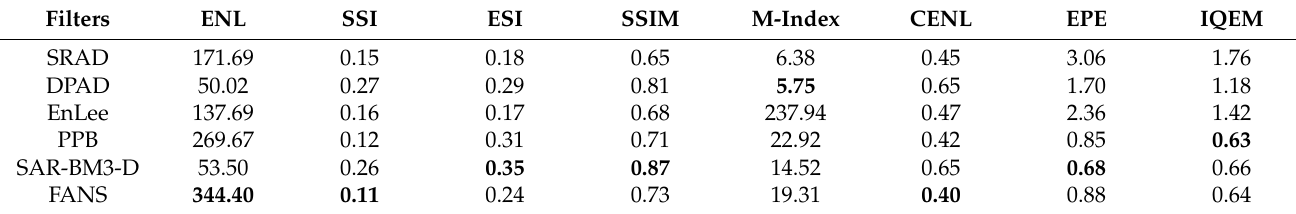
Table 3. Index evaluation of the GF-3 SAR